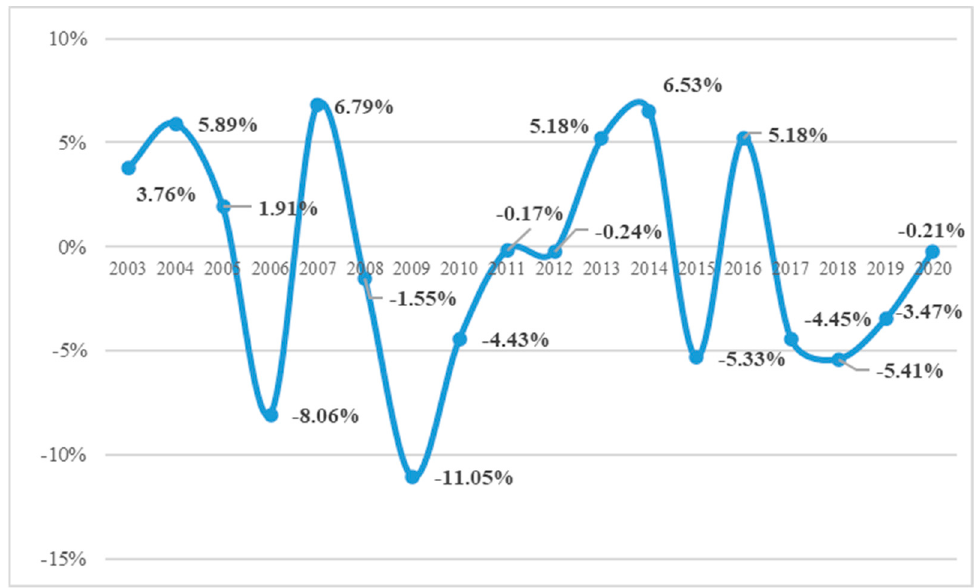
Figure 3. Ratio of the budget deficit/surplus to the annual budget revenues for 2003–2020 (in %) for the city of Piekary Ś l ą skie. Source: own elaboration.